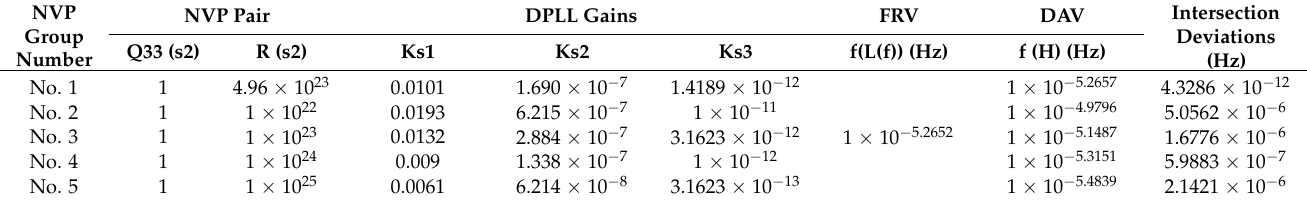
Table 1. Table of cross point deviation in frequency domain under different parameter selection.